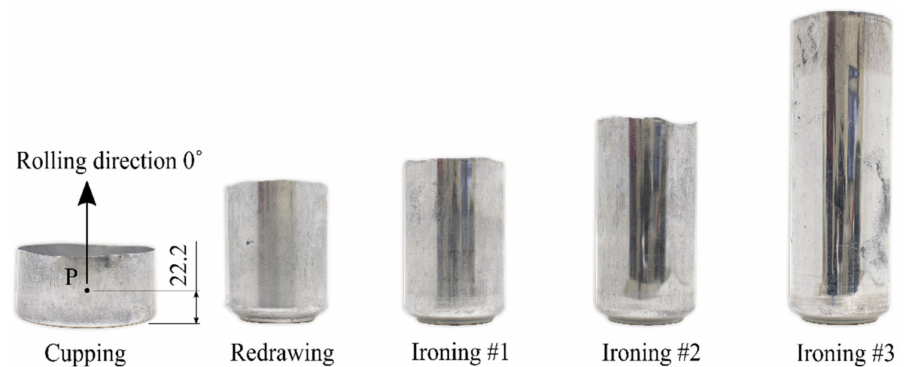
Figure 3. First five steps of the forming process of a beverage